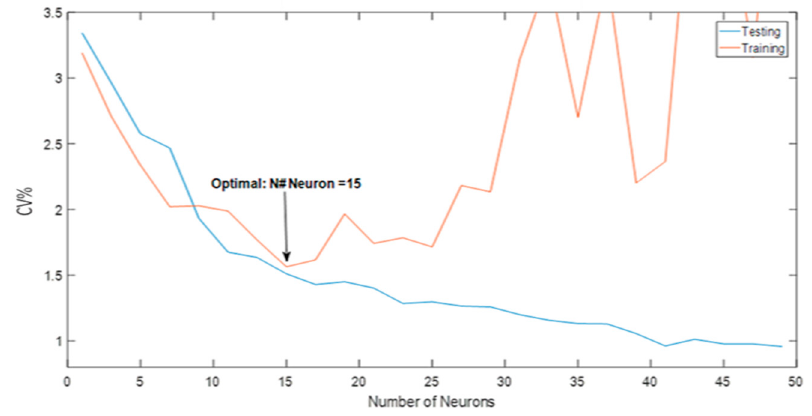
Figure 8. CV% results as a function of the number of neurons for the training and testing period of the DX model.